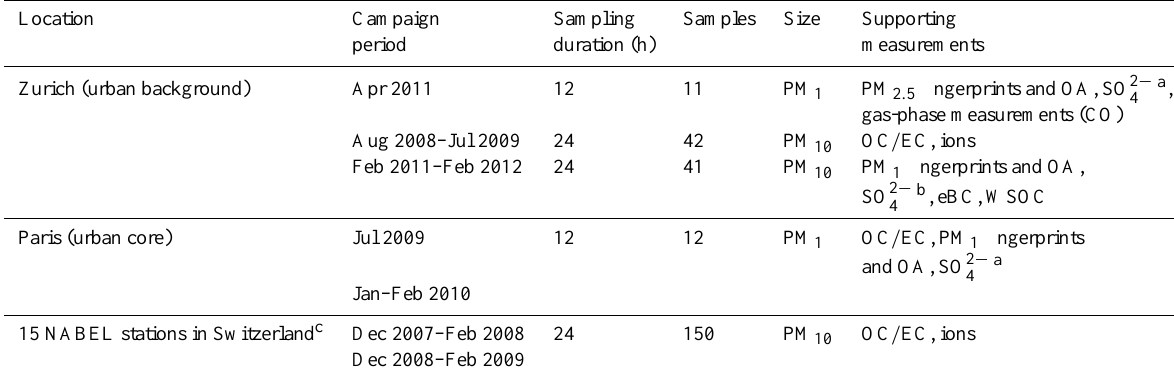
Table 1. Filter samples and available supporting measurements used in this